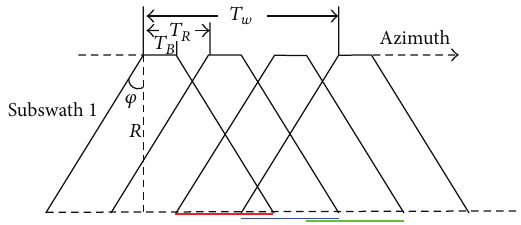
Figure 3: One subswath of spaceborne WAS mode with three revisits.